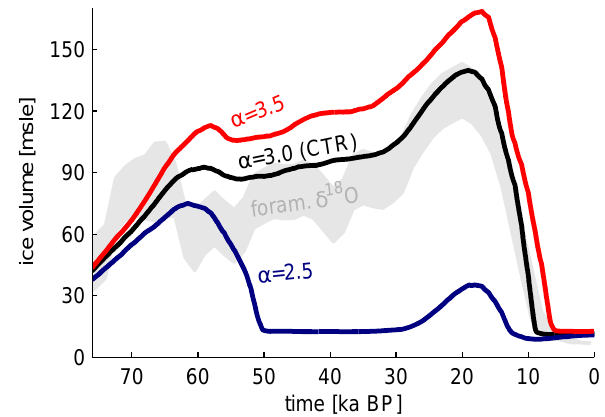
Figure 7. Sensitivity of the simulated Northern Hemisphere land ice volume to the parameter α , which scales the effect of CO 2 on the longwave radiation in the atmosphere (Sect. 2.1). The default value as used in this study is α =3 (CTR). Gray shading indicates sea level reconstructions from foraminiferal oxygen isotope ratios (Waelbroeck et al., 2002).